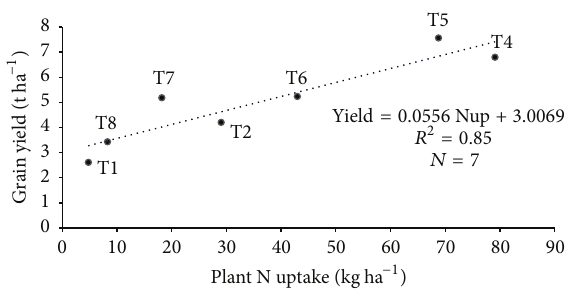
Figure 2: Relationship between N uptake and grain yield under different treatments, where Nup = nitrogen